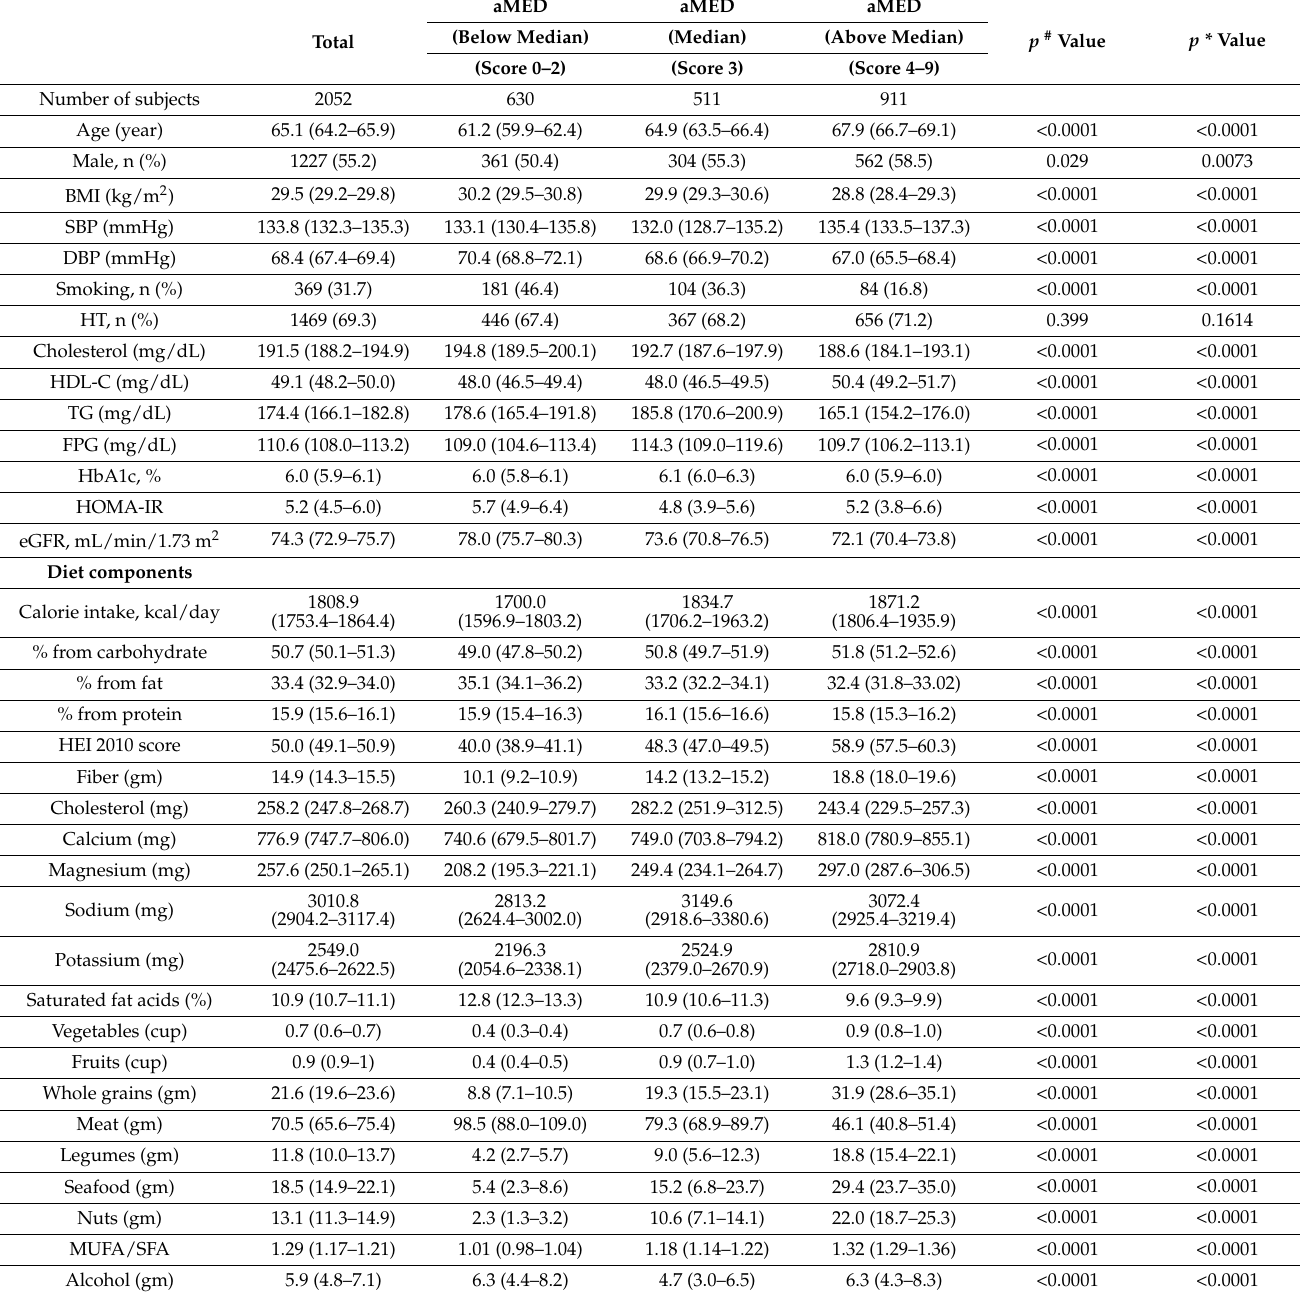
Table 1. Baseline demographic data of NHANES participants with coronary heart disease or stroke in alternative Mediterranean diet